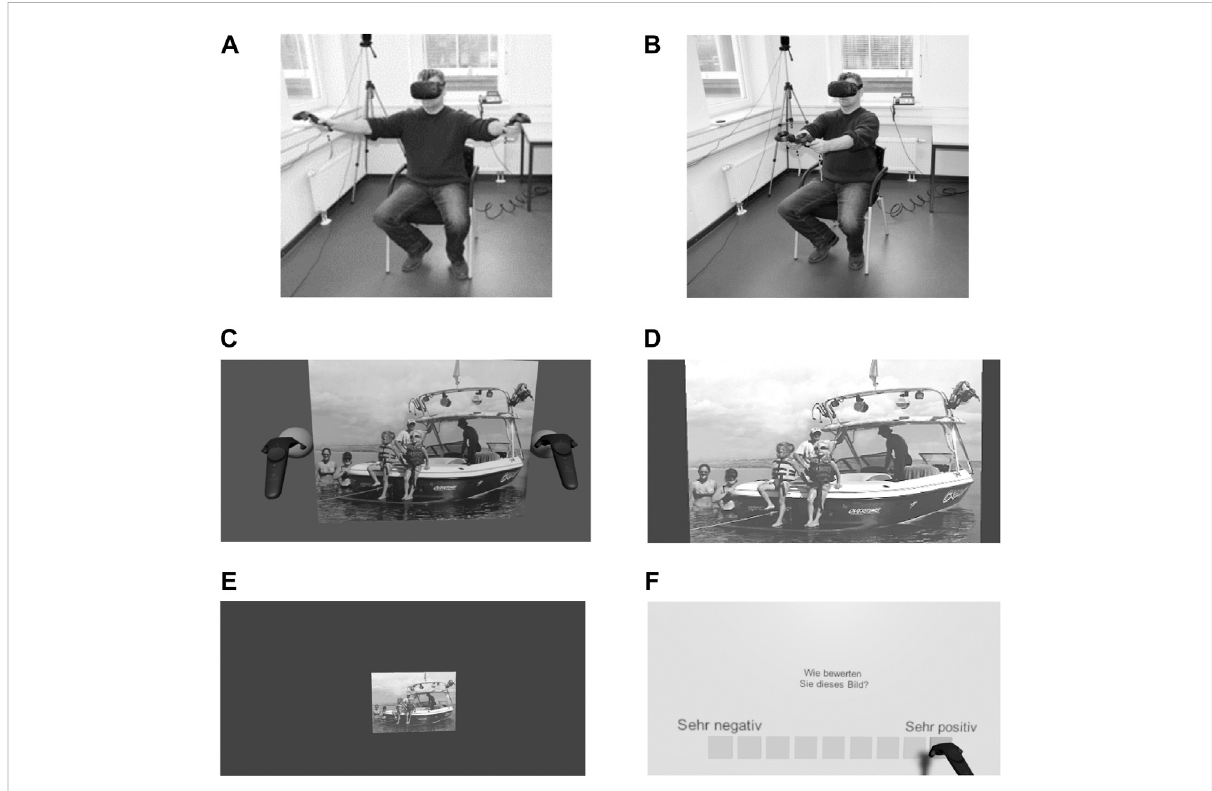
FIGURE 1 VRSetup. (A) Open-ArmsGesture; (B) Closed-Arms Gesture; (C) Thecontrollerstouchthe3D-knobsnearthecolored 2D-picture immediately before performing the Zoom Gesture; (D) The picture after zooming in; (E) The picture after zooming out; (F) The rating panel after performing the Zoom